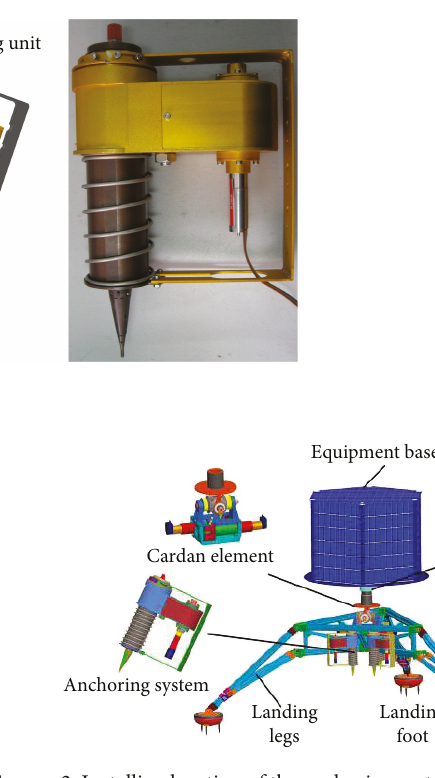
Figure 2: Installing location of the anchoring system on the landing